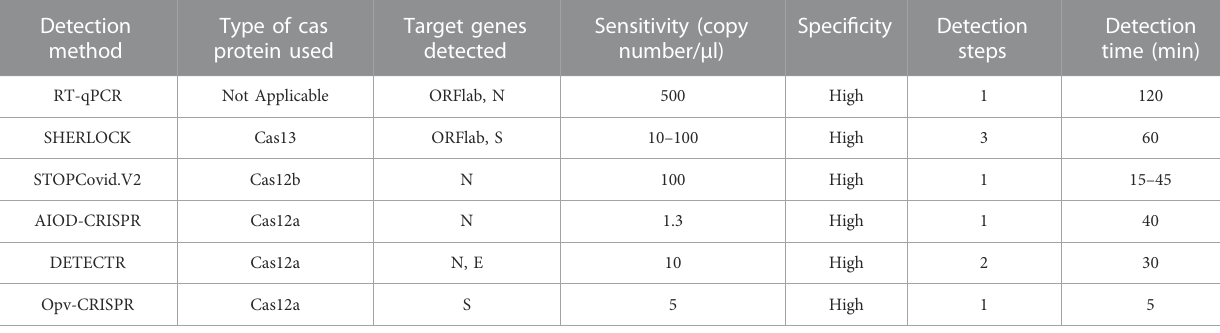
TABLE 4 Comparisons of various SARS-CoV-2 test methods based on CRISPR-Cas and RT-qPCR. Detection